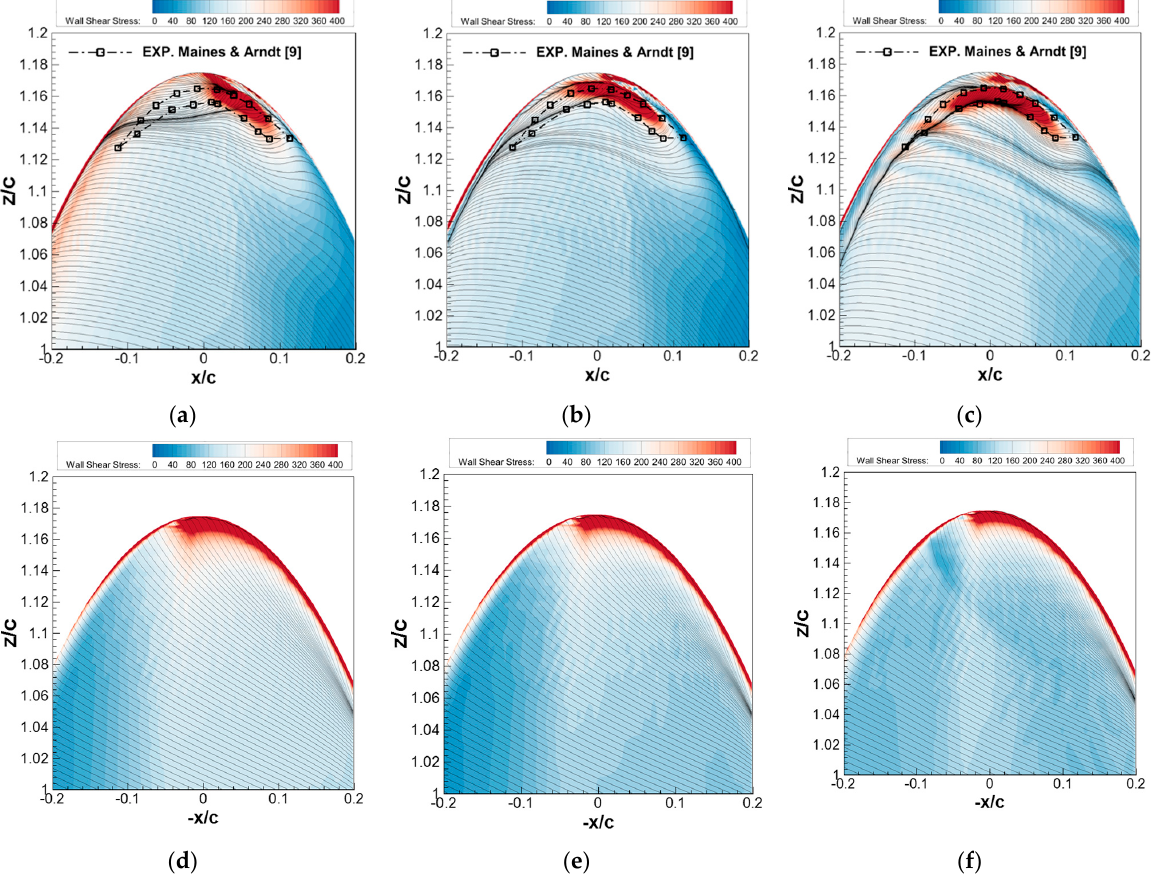
Figure 10. Limiting streamlines and wall shear stress distribution on the suction and pressure surfaces of the foil: ( a ) suction